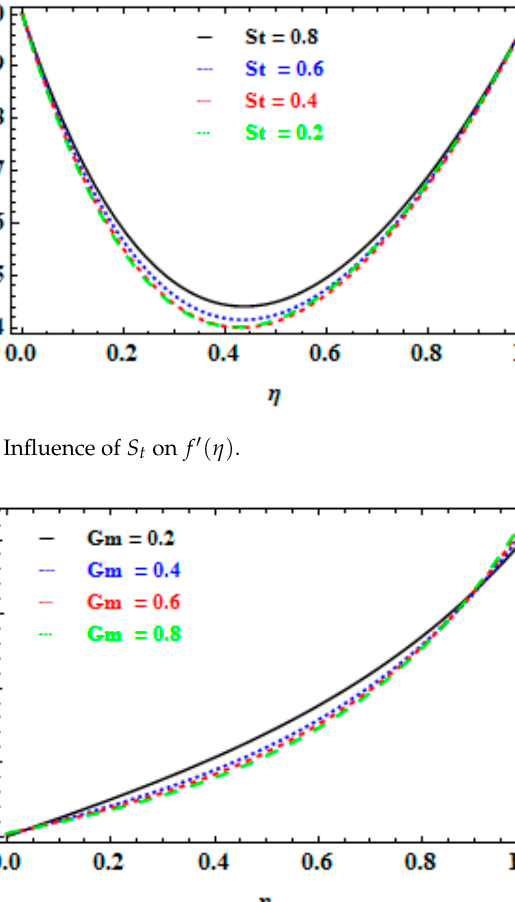
β β on 𝑓 (cid:4593) ( 𝜂 ) . on 𝑓 (cid:4593) ( 𝜂 ) .